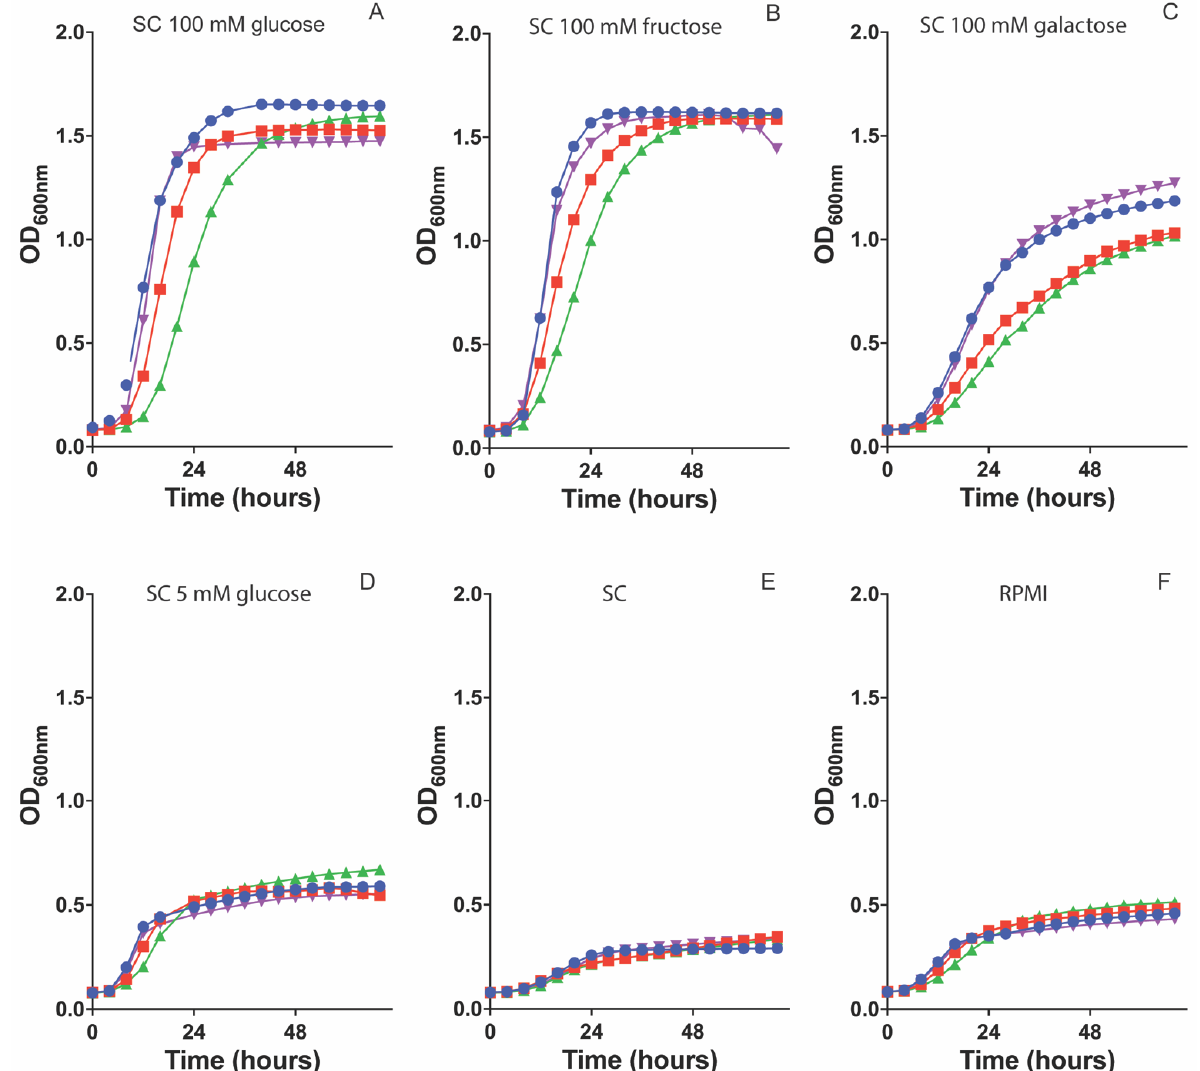
Figure 1. Deletion of CDC25 and RAS1 causes a reduced growth rate in liquid medium. The different strains were grown in different media: SC supplemented with 100 mM glucose ( A ), 100 mM fructose ( B ), 100 mM galactose ( C ), 5 mM glucose ( D ), SC ( E ), and RPMI ( F ). The OD 600 was followed over time for 72 h. WT ( ● ), cdc25 ( ■ ), ras1 ( ▲ ), and ras2 ( ▼ ). The data represent the average of two independent experiments each consisting of three biological repeats and three technical repeats. Statistical analysis was done by using an ANOVA test with Bonferroni correction (Table